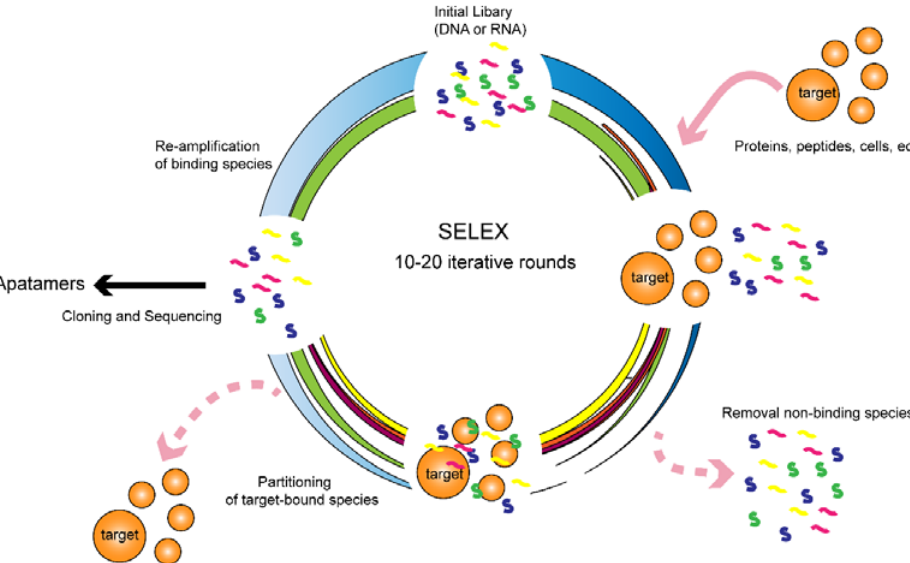
Figure 1. Schematic illustration of the SELEX process for the DNA and RNA library.